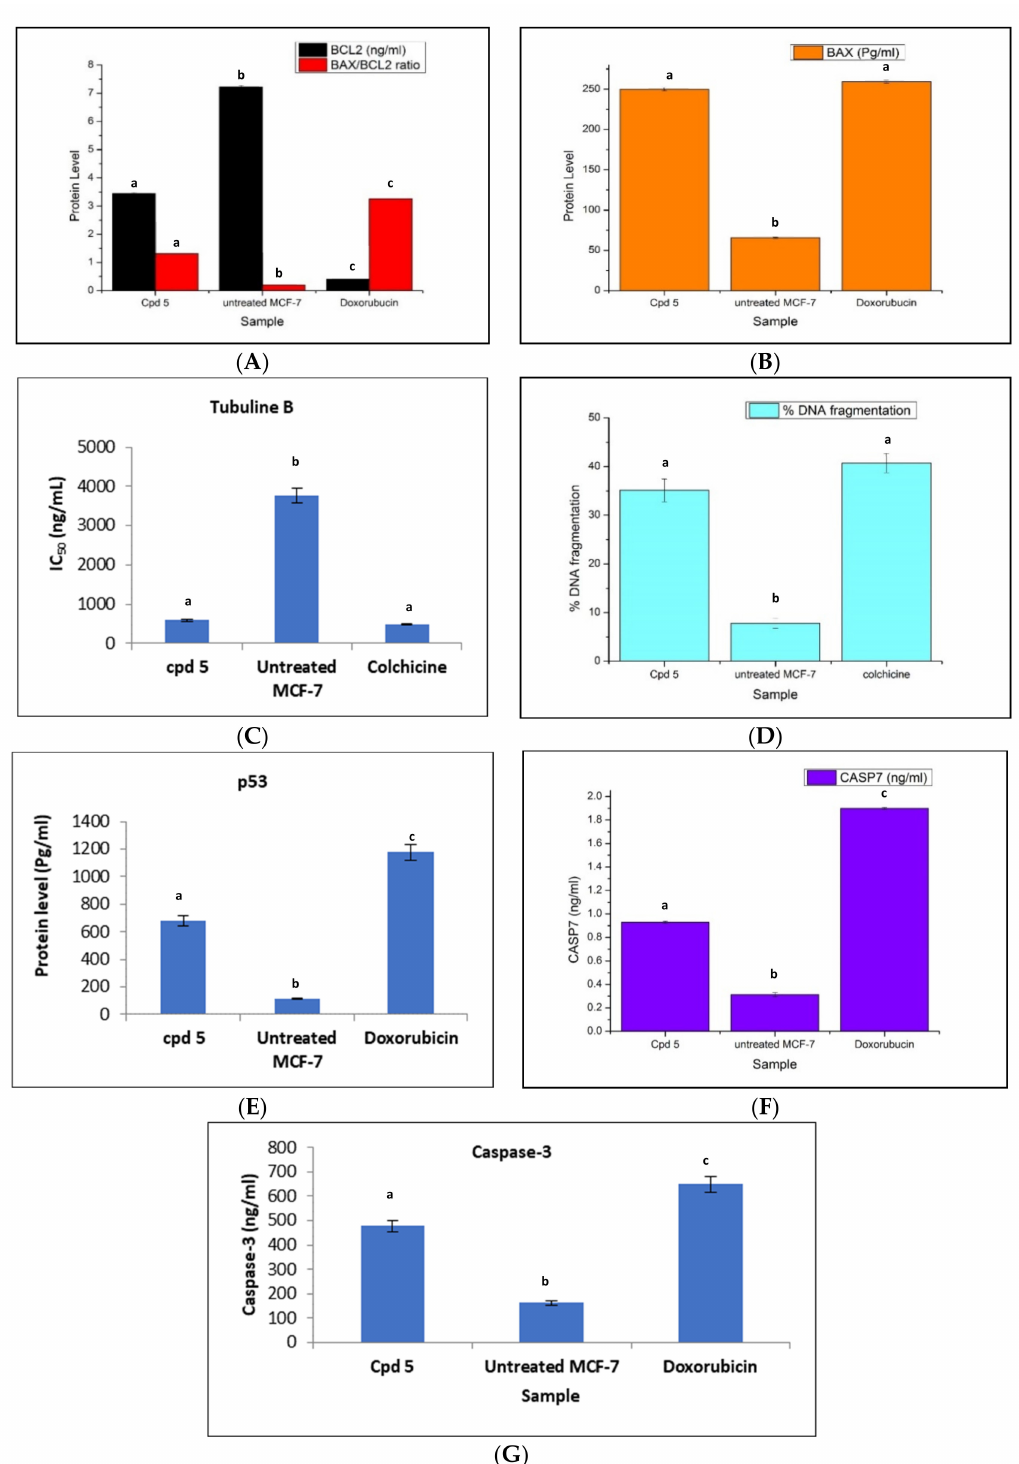
Figure 5. Quantitative assessment (mean ± SD) protein levels of ( A ) Bax/BCL-2 ratio, ( A ) Bcl-2 (ng/mL), ( B ) Bax (Pg/mL), ( C ) IC 50 (ng/mL) on tubuline B, ( D ) % DNA fragmentation, ( E ) p53 (Pg/mL), ( F ) caspase-7(ng/mL) and ( G ) caspase- 3 (ng/mL) for compound 5 , each value is the mean of three replicates, SD = standard deviation. Statistical analysis was done using one-way analysis of variance (ANOVA) using the CoStat computer program accompanied by the least significant level (LSD) between groups at p < 0.05. Unshared letters (a, b, and c) are significant values between groups for each parameter at p <